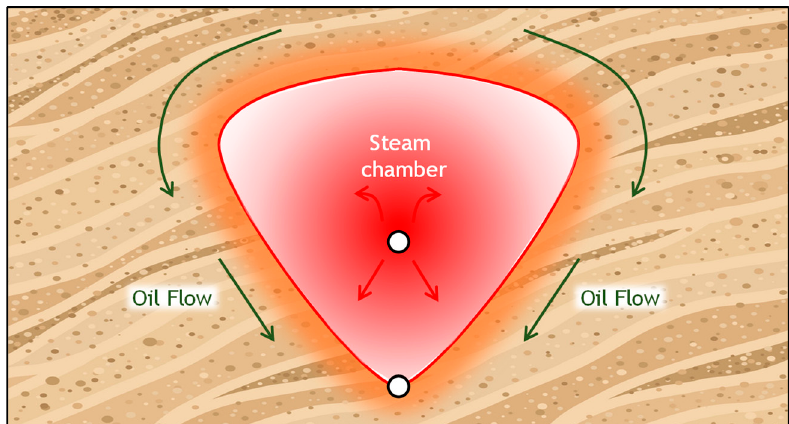
Figure 2. Two-dimensional view of the steam chamber in a steam assisted gravity drainage (SAGD) process. The steam chamber is saturated with the injected steam. The oil flows at the interface of the chamber where the temperature corresponds to the saturation temperature at the injection pressure.